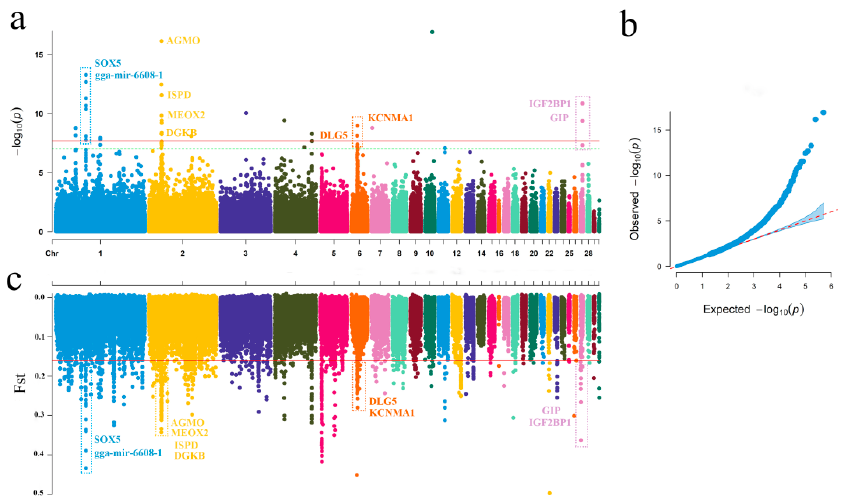
Figure 1. Selective signatures identified via GWAS and F ST . ( a ) Manhattan plot of GWAS values. The greenand red lines in the Manhattan plot represent genome-wide alpha level 1.00 × 10 − 7 and 2.00 × 10 − 8 adjusted based on the Bonferroni method with 498,363 SNPs after quality control, respectively. ( b ) Q-Q plot of GWAS values. Sudden separation of observed p values from expected p values indicate that traits are indeed affected by SNPs. ( c ) Distributionof Weir- F ST values.